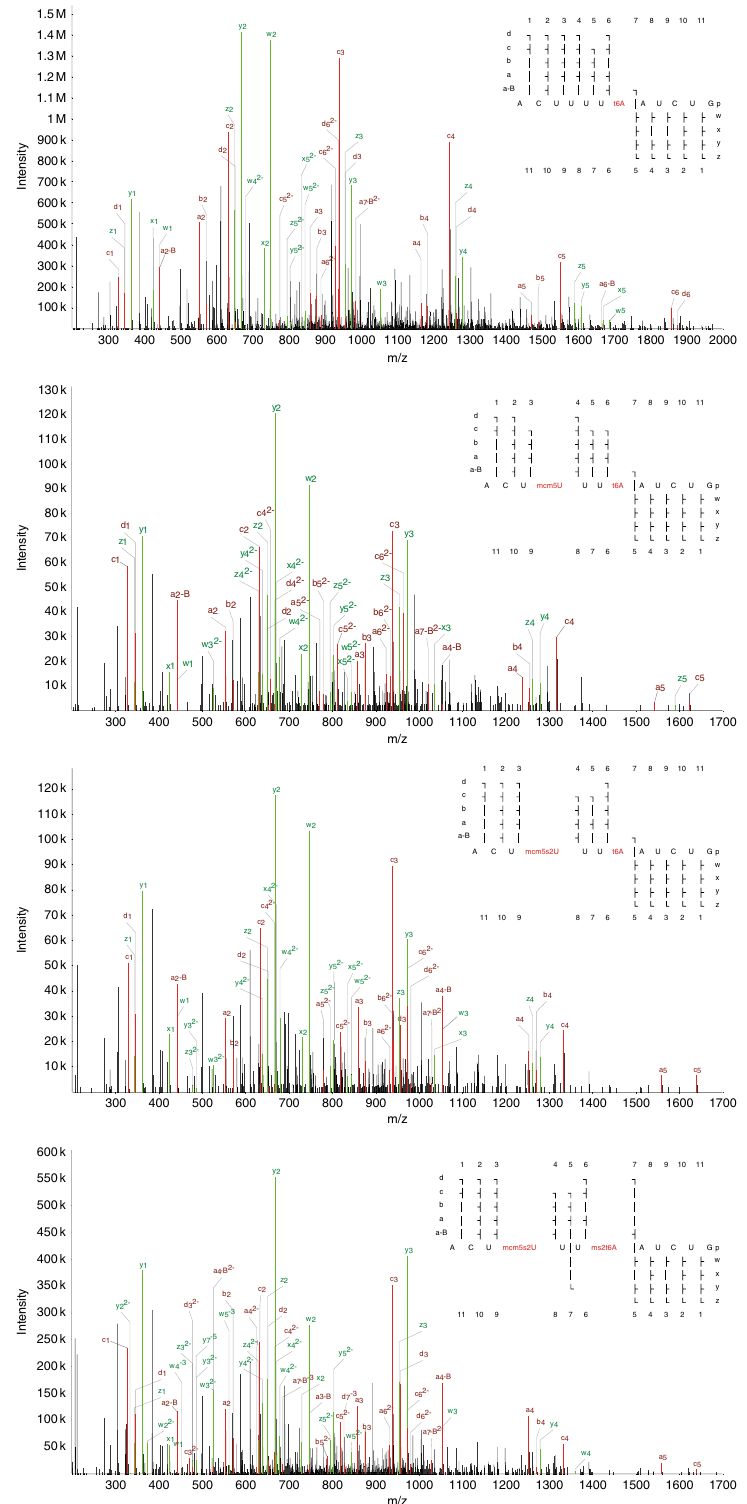
Fig. 6 Annotated spectra of four oligonucleotides originating from tRNA-Lys TTT . Matched a-B/a/b/c/d ions are shown in red, w/x/y/z ions in green. All oligonucleotides cover the same region around the anticodon, but represent different modi fi cation states, evocative of stepwise addition and conversion of modi fi cations by the associated enzymes. Each of these spectra had a precursor with a charge state of − 5 with the exception of “ ACUUUU(t6A)AUCUG ” , which was − 3. All of these spectral assignments had a hyperscore of at least 140 in